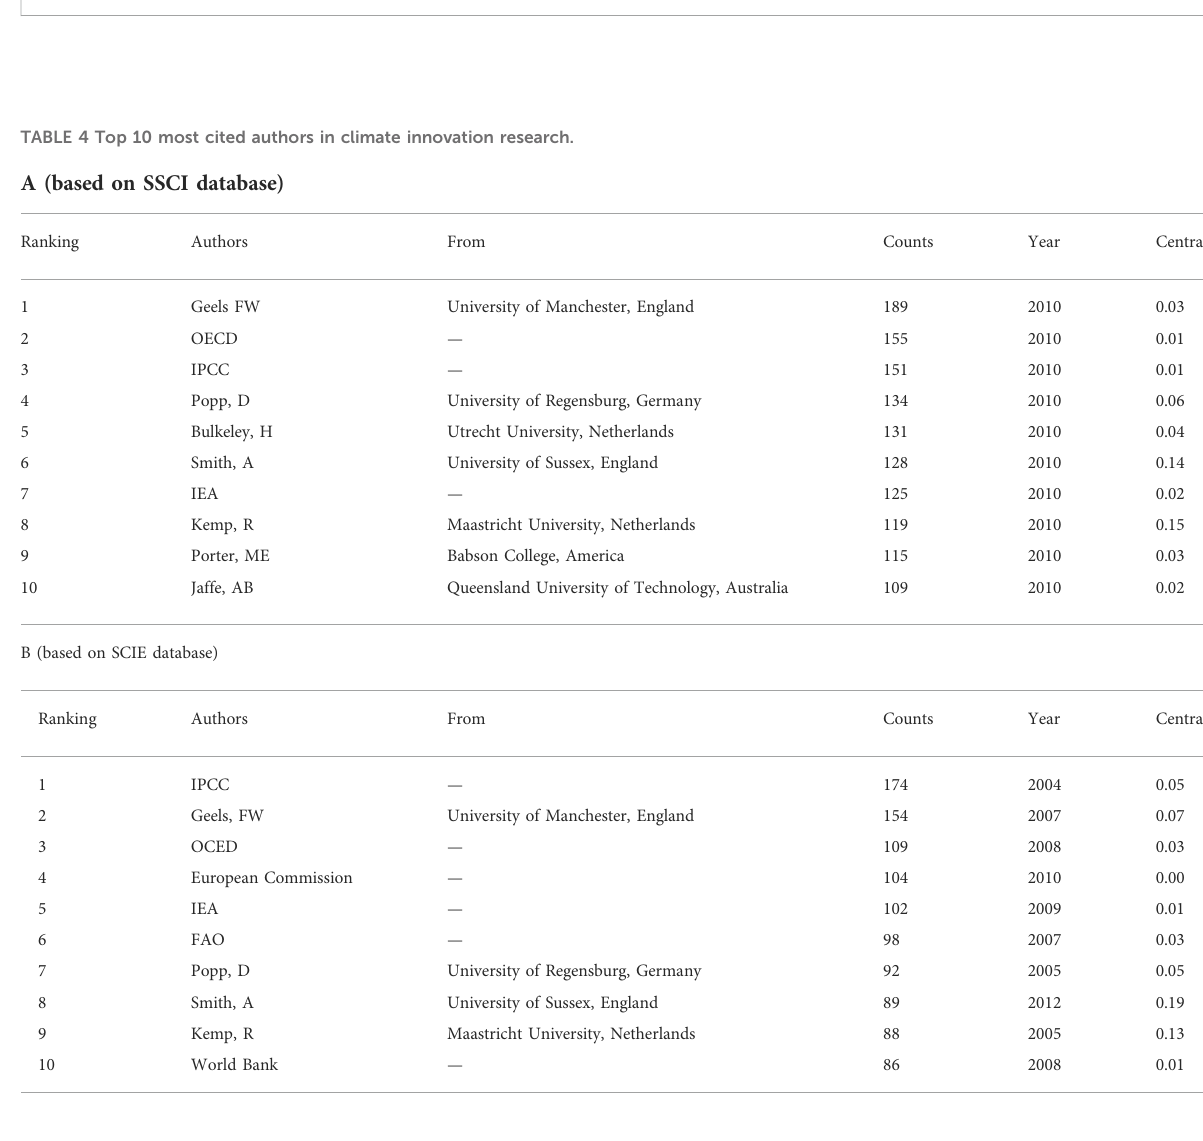
FIGURE 4 Map of the author co-citation network of climate innovation research. (A) refers to the SSCI database and (B) refers to the SCI database.